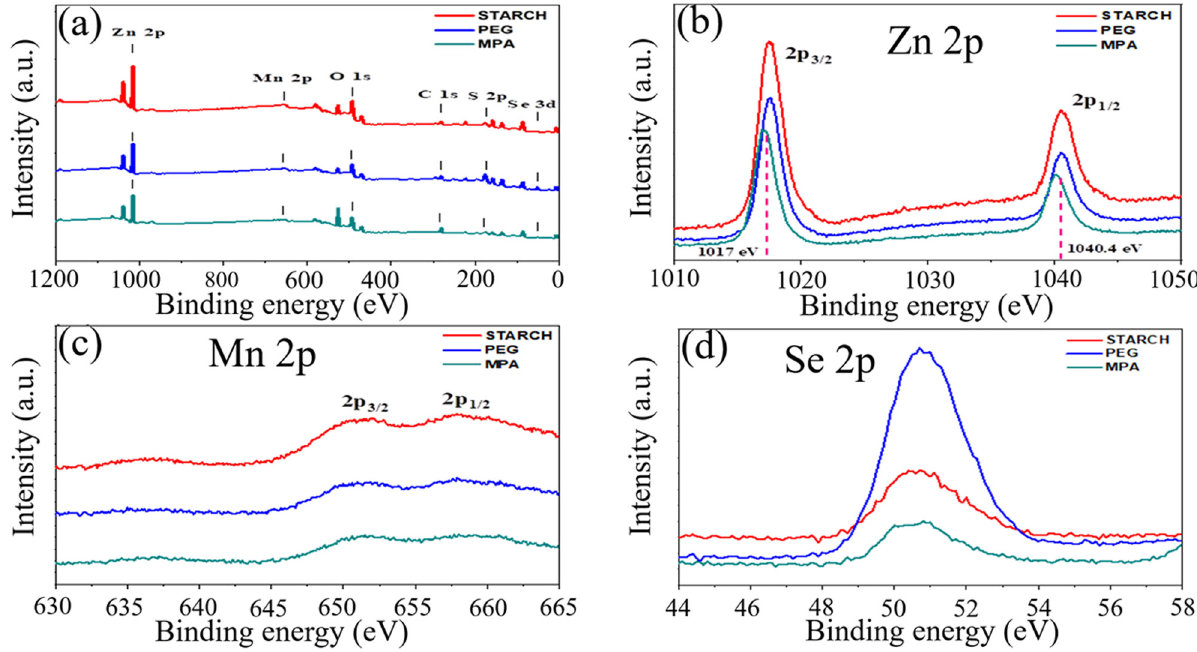
Figure 3: The XPS spectra of ZnSe:Mn ( 5% ) at various capping